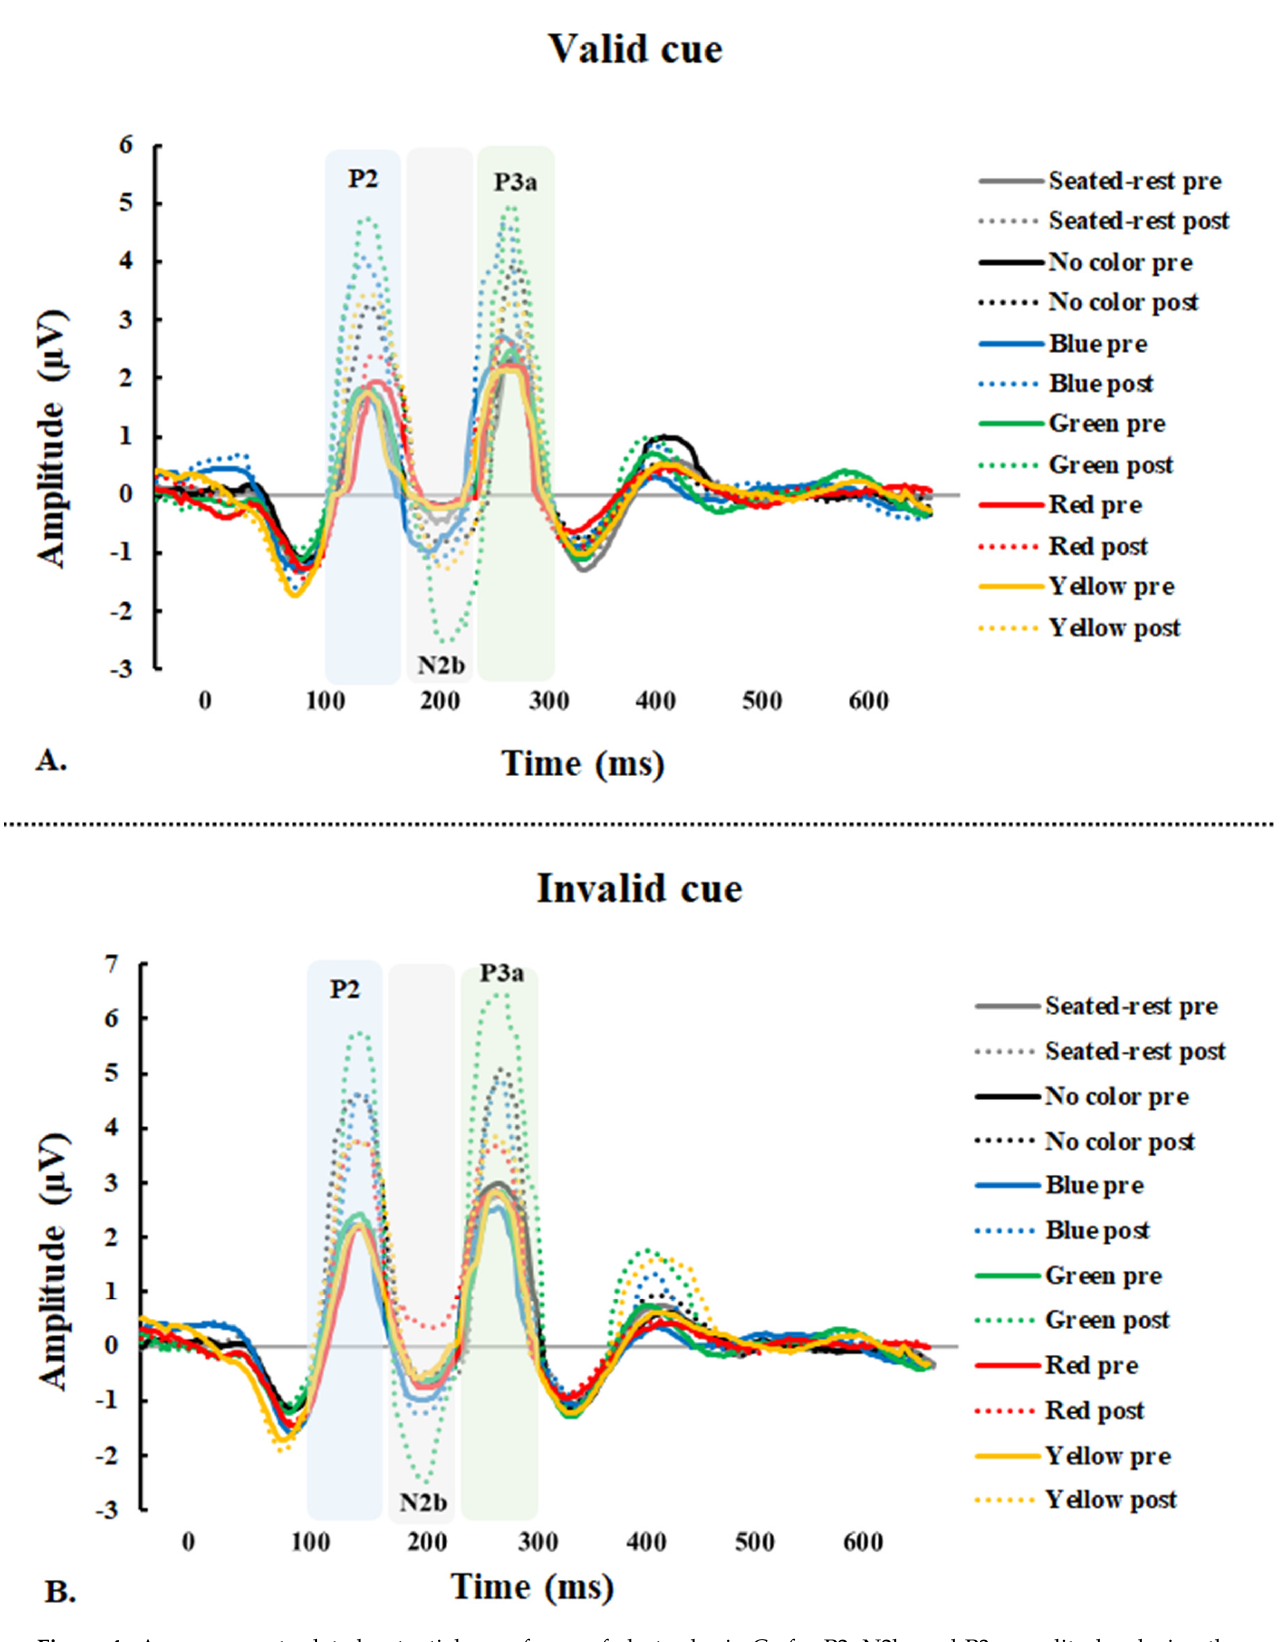
Figure 4. Average event-related potential waveforms of electrodes in Cz for P2, N2b, and P3a amplitudes during the Kanizsa triangle task in seated-rest and pre and post-exercise with five different interventions. ( A ) valid cue; ( B ) invalid cue.